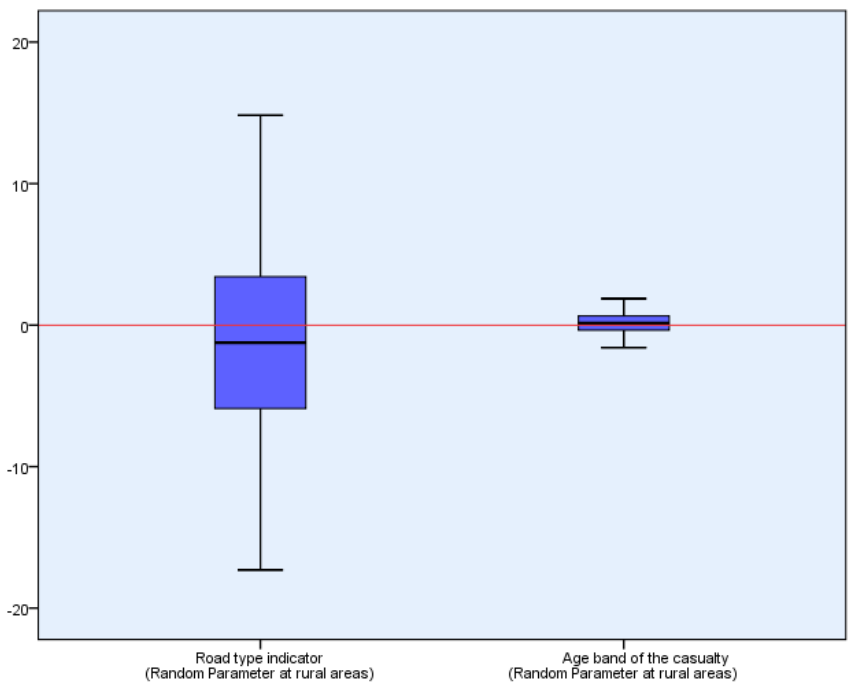
Figure 3. Boxplots illustrating the random parameters’ distributions in the accident injury severity model for rural areas (the lower and upper limits of the box reflect the interquartile range, the thick line in the middle of the box represents the median, the red line indicates the zero value, and the whiskers are defined by the minimum and maximum values of the distribution).